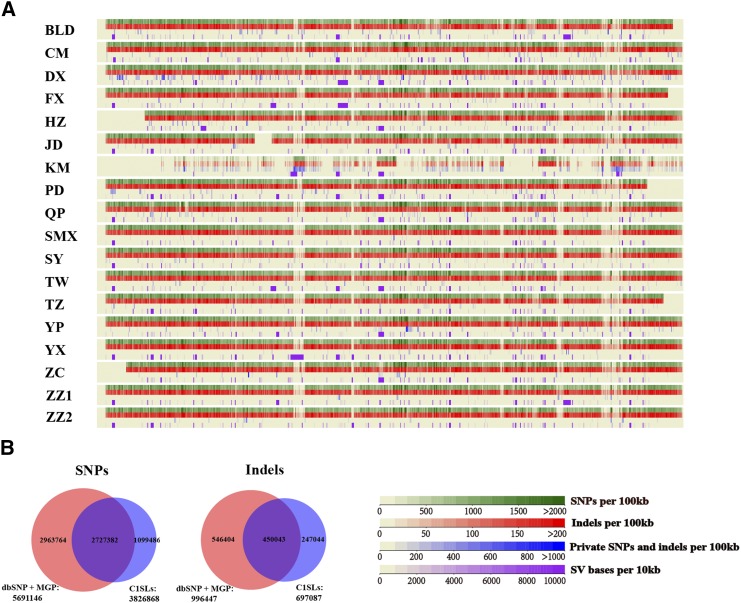
Overview of variants called from C1SLs. (A) Distribution of SNPs, indels, private variants, and structural variants on Chr 1 in C1SLs. (B) Venn diagram of comparison between C1SLs and MGP and dbSNP142 data sets of identified SNPs and indels on Chr 1.